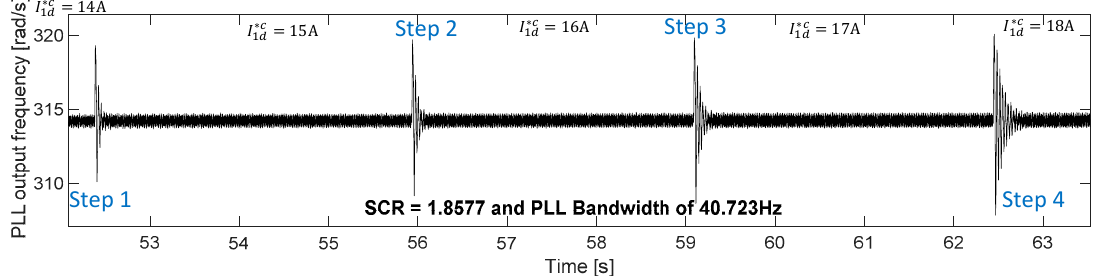
Figure 17. Transient response of frequency at the PLL output for a SCR of 1.8577 and for a PLL BW of 40.723 Hz, in the four steps considered in for the validation—Matlab data logging of the experimental waveforms. Table 9. Comparison between the damping of modes 7 and 8 given by the proposed model and the those found in the experimental system, for SCR = 1.8577 and PLL bandwidth equal to 40.723